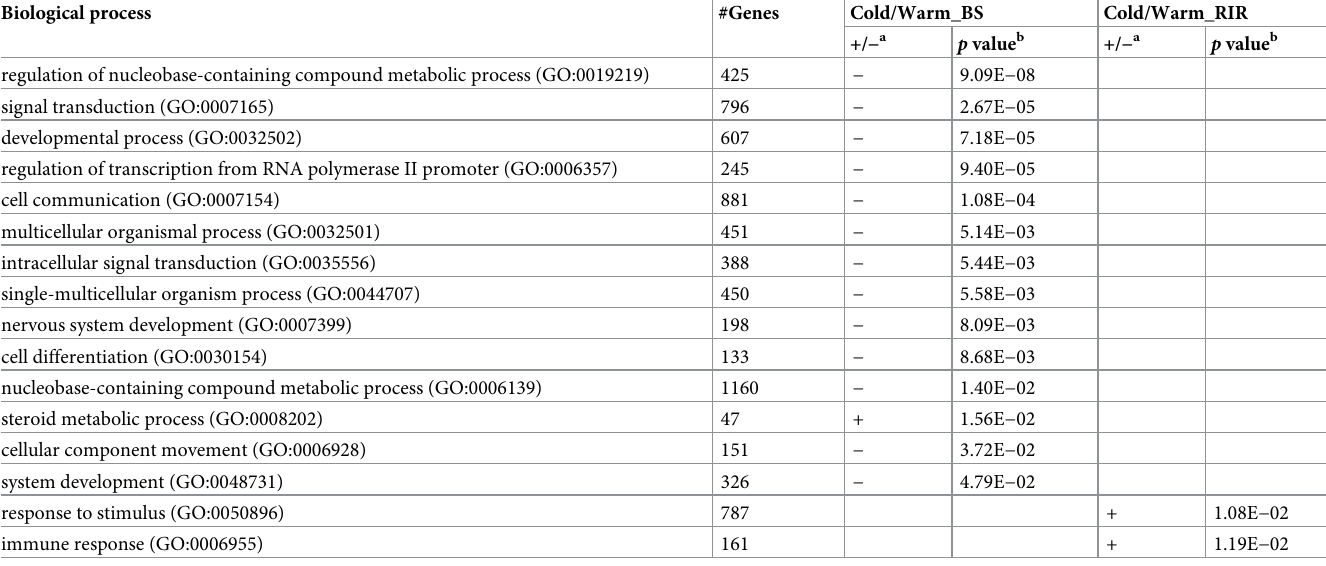
Table 7. GO enrichments for gene expression plasticity in BS and RIR chicken